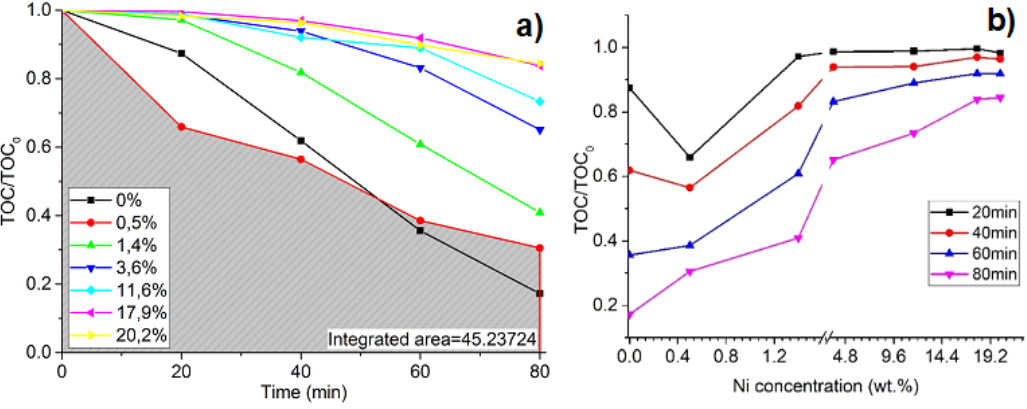
Figure 8. Degradation of oxalic acid in time as a function of Ni concentration in TiO 2 thin films, where ( a ) degradation of oxalic acid in time at different Ni wt % concentrations and ( b ) photocatalysis process dependence on Ni wt % dopant concentration .